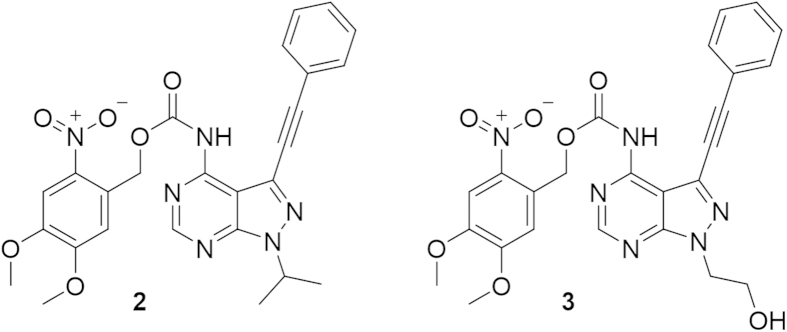
Compounds 2 and 3.